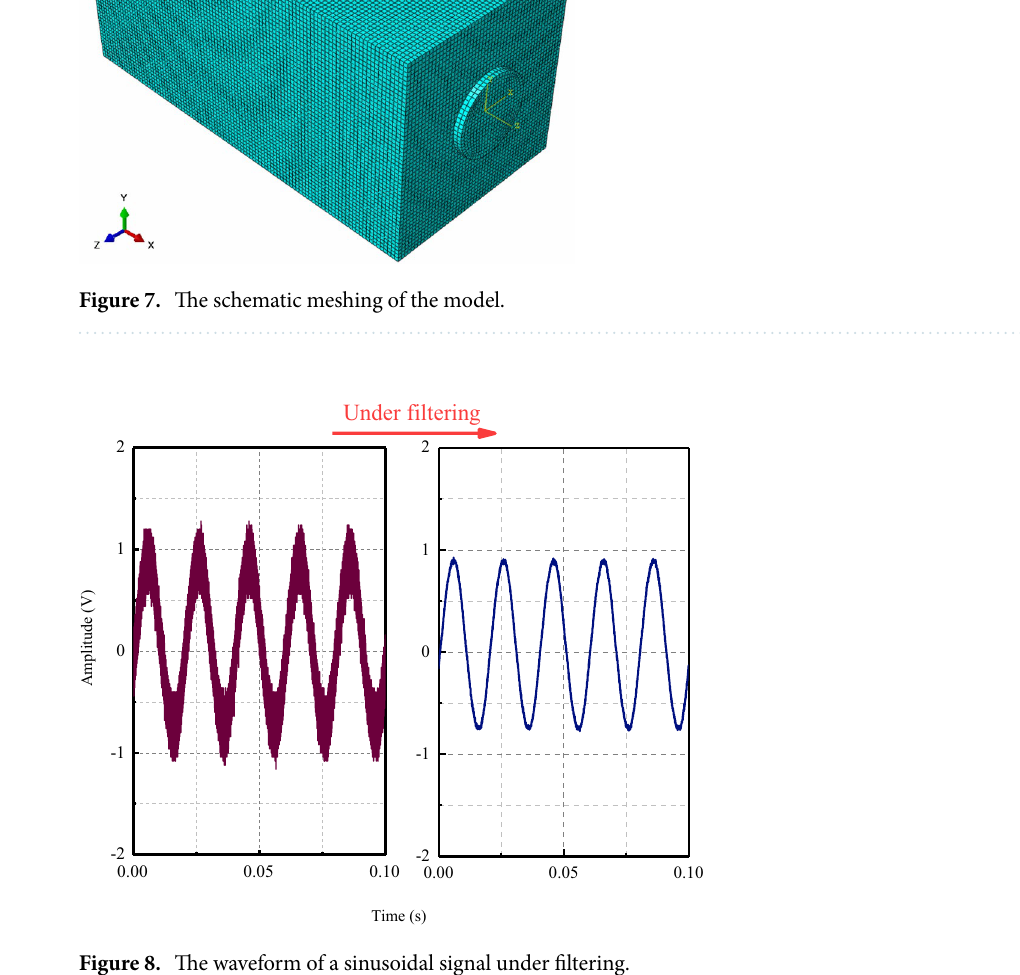
Figure 8. The waveform of a sinusoidal signal under